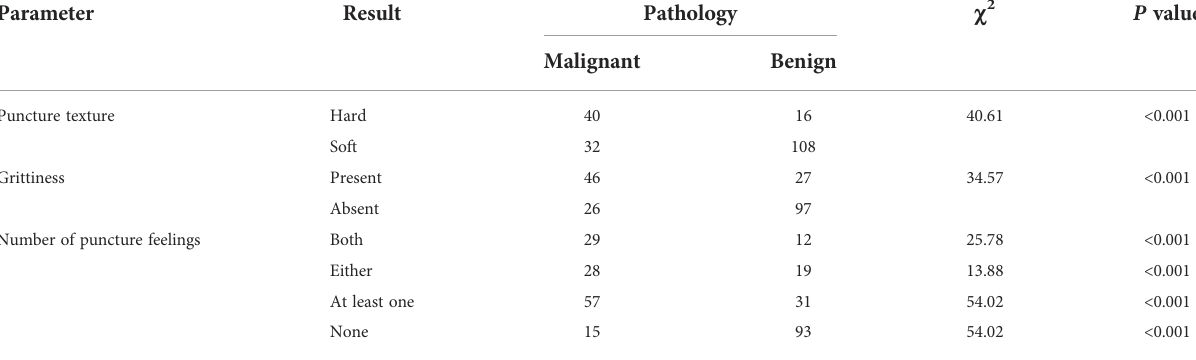
TABLE 2 Differences in the puncture feeling of thyroid nodules with indeterminate FNA fi ndings.